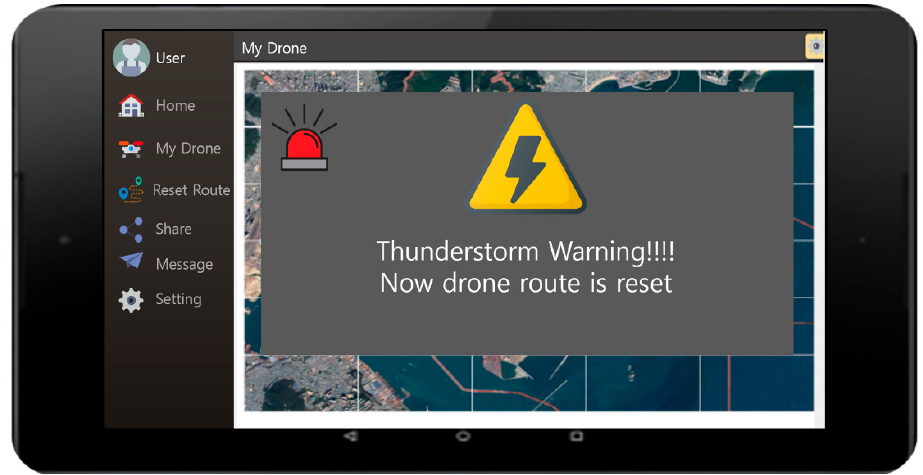
Figure 31. User interface showing the lightning/thunderstorm warning screen.